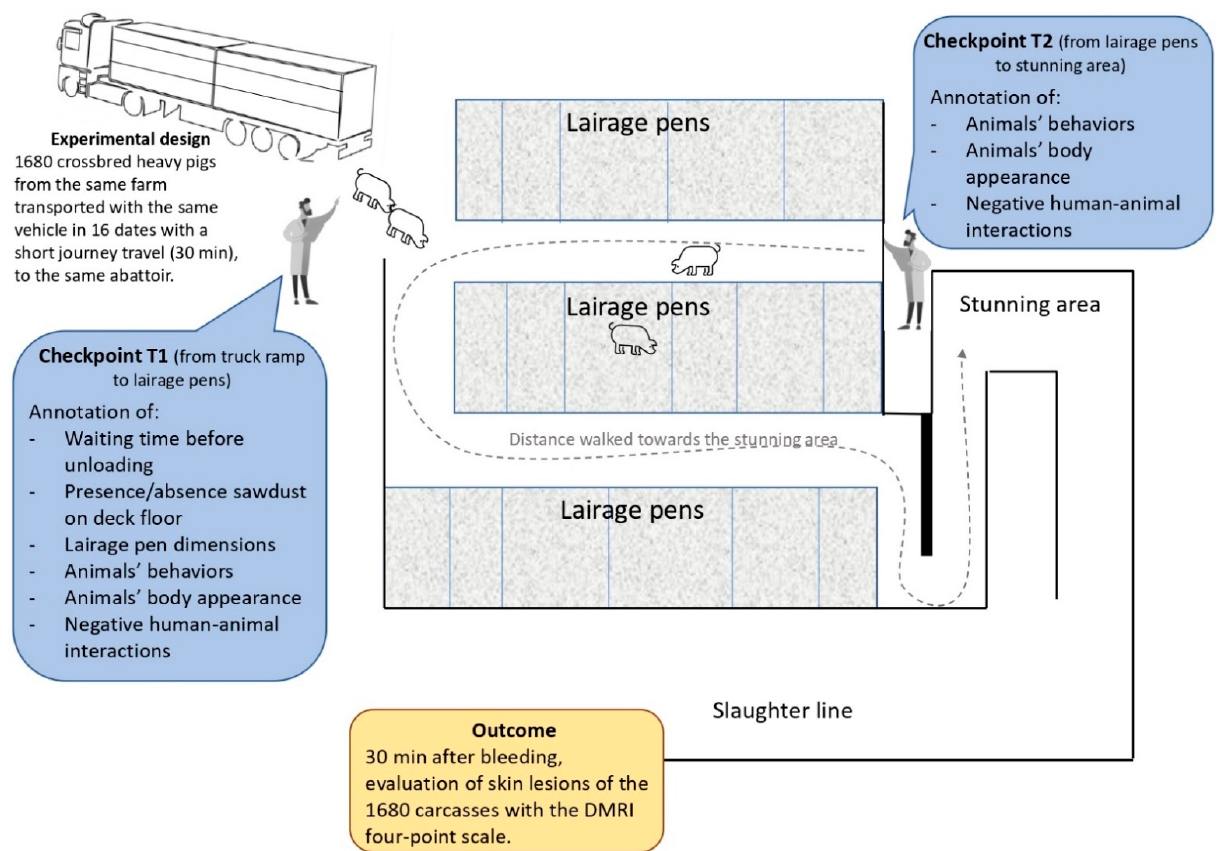
Figure 1. Graphical representation of the experimental design. The checkpoints (T1 and T2) used to annotate the animal behaviors, body appearance and negative human–animal interactions are reported on a simplified plan of the lairage and stunning area of the commercial abattoir located in Northern Italy.